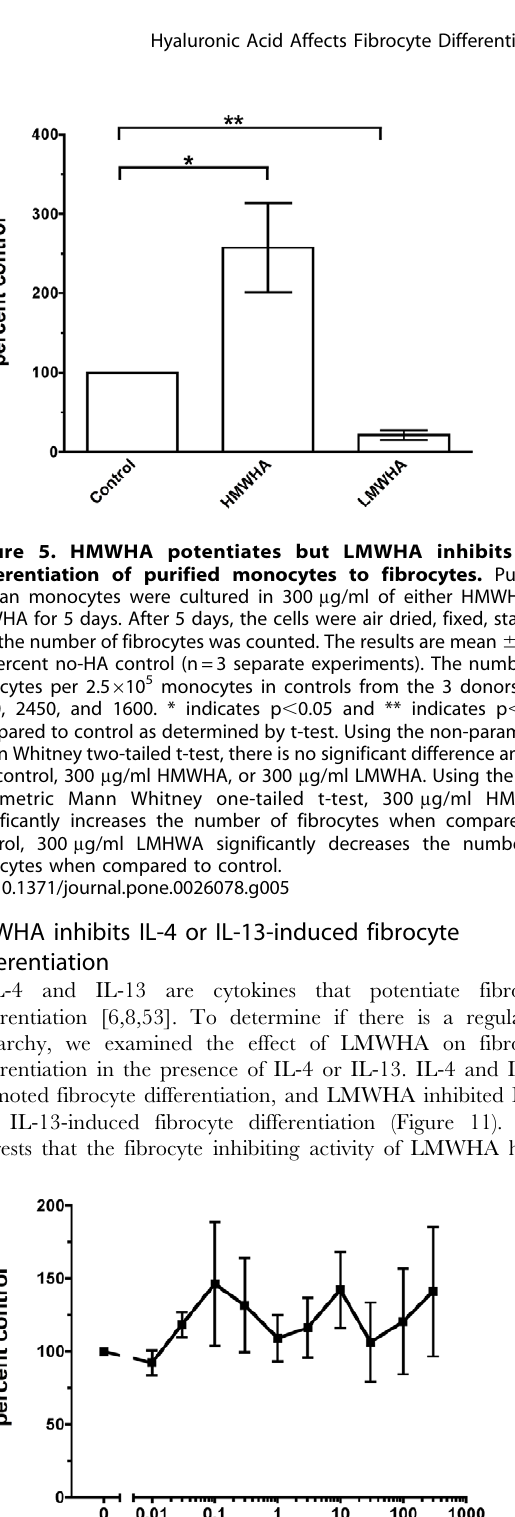
Figure 6. Oligo hyaluronic acid does not affect fibrocyte differentiation. Human PBMC were cultured in different concentra- tions of oligo hyaluronic acid for 5 days. After 5 days, the cells were air dried, fixed, stained, and the number of fibrocytes was counted. The results are mean 6 SEM of percent control (n=3 separate experiments). The number of fibrocytes 2.5 6 10 5 PBMC in controls from the 3 donors was 4150, 2560, and 575.